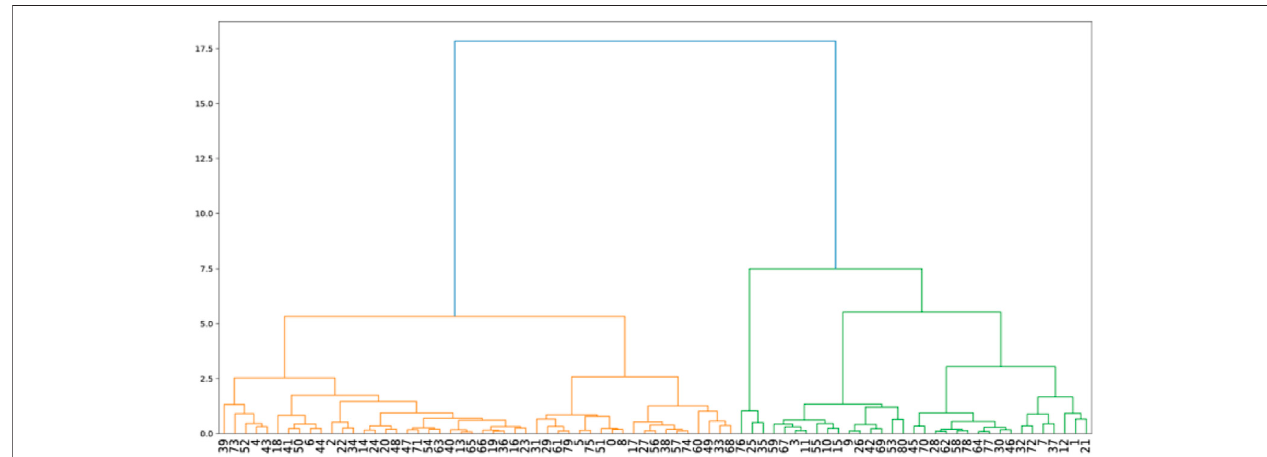
FIGURE3| Pedigreechartofhierarchical agglomerative clustering.Thex-axis represents 81samples,and they-axis istherelative distancebetweenthesamples. Green and orange lines represent the clustering results obtained by hierarchical agglomerative clustering for the fi rst and second type of TC tracks, respectively.